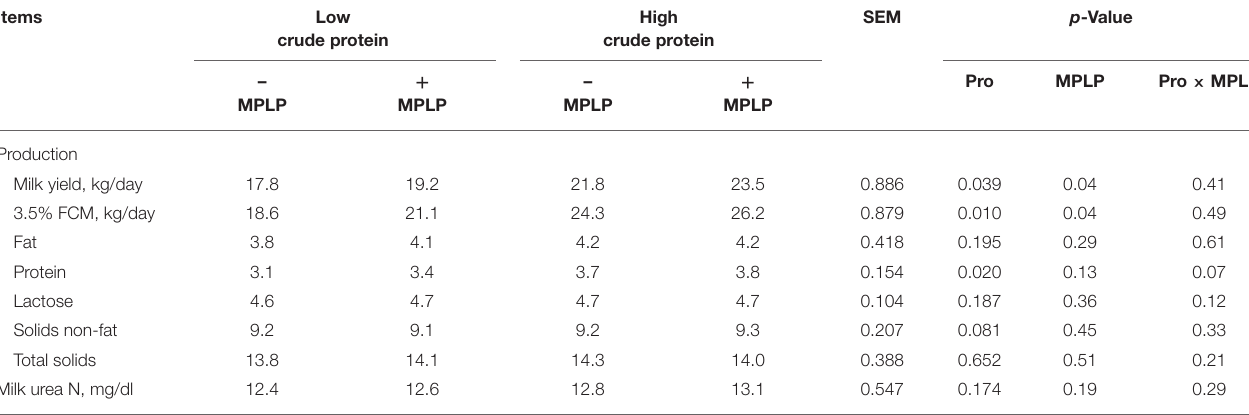
TABLE 6 | Effect of crude protein level and mangosteen peel liquid-protected soybean meal on milk yield and composition in lactating dairy cows. Items Low High SEM p crude protein crude protein